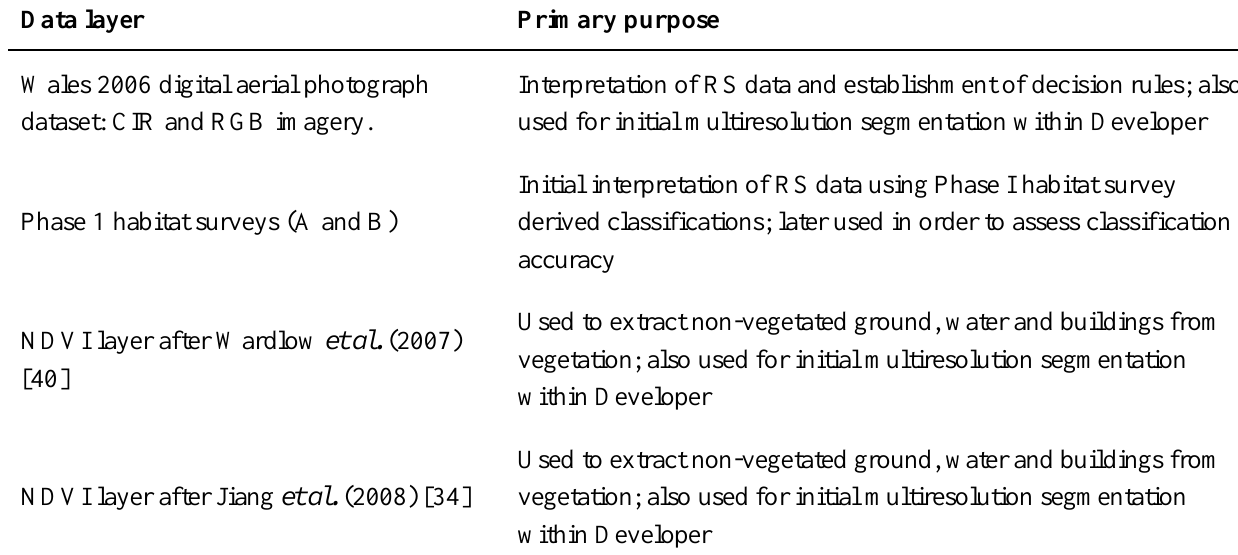
Table 2. Data layers used for the classification of Japanese Knotweed s.l.